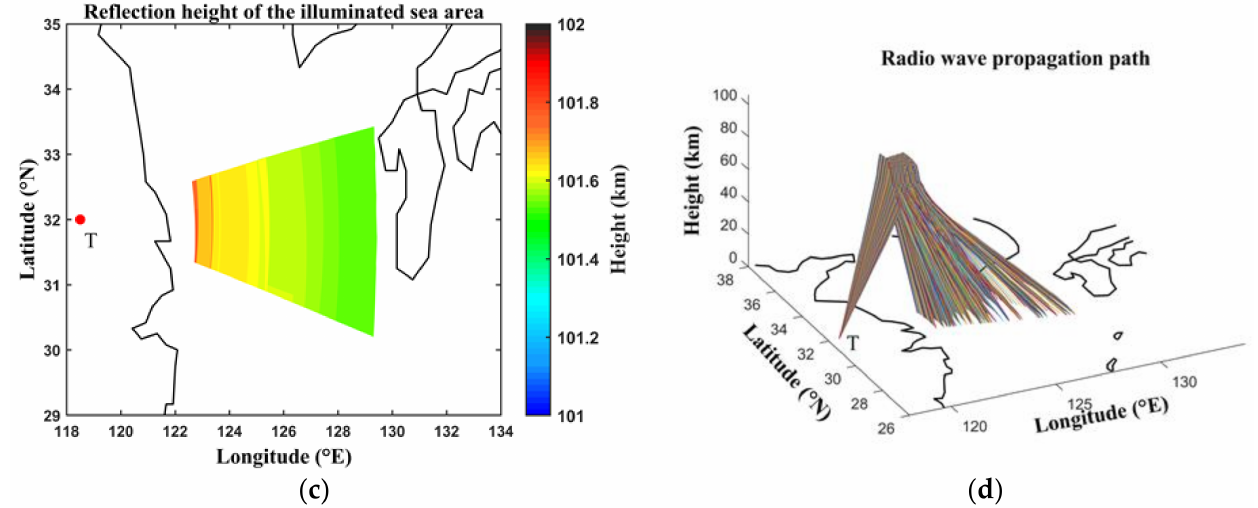
Figure 6. Parameters related to the reflection of radio waves by the ionosphere. ( a ) Group path ( P G ). ( b ) Grazing incidence angles ( α i ). ( c ) Reflection heights. ( d ) Radio waves’